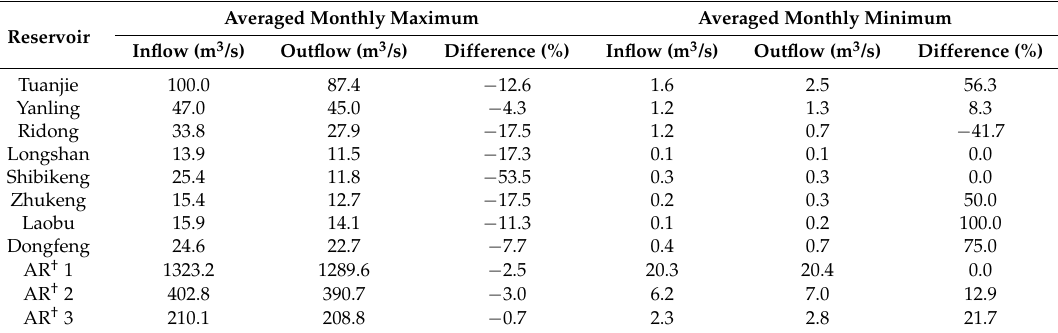
Table 4. Effects of reservoirs on the monthly maximum and minimum flow.